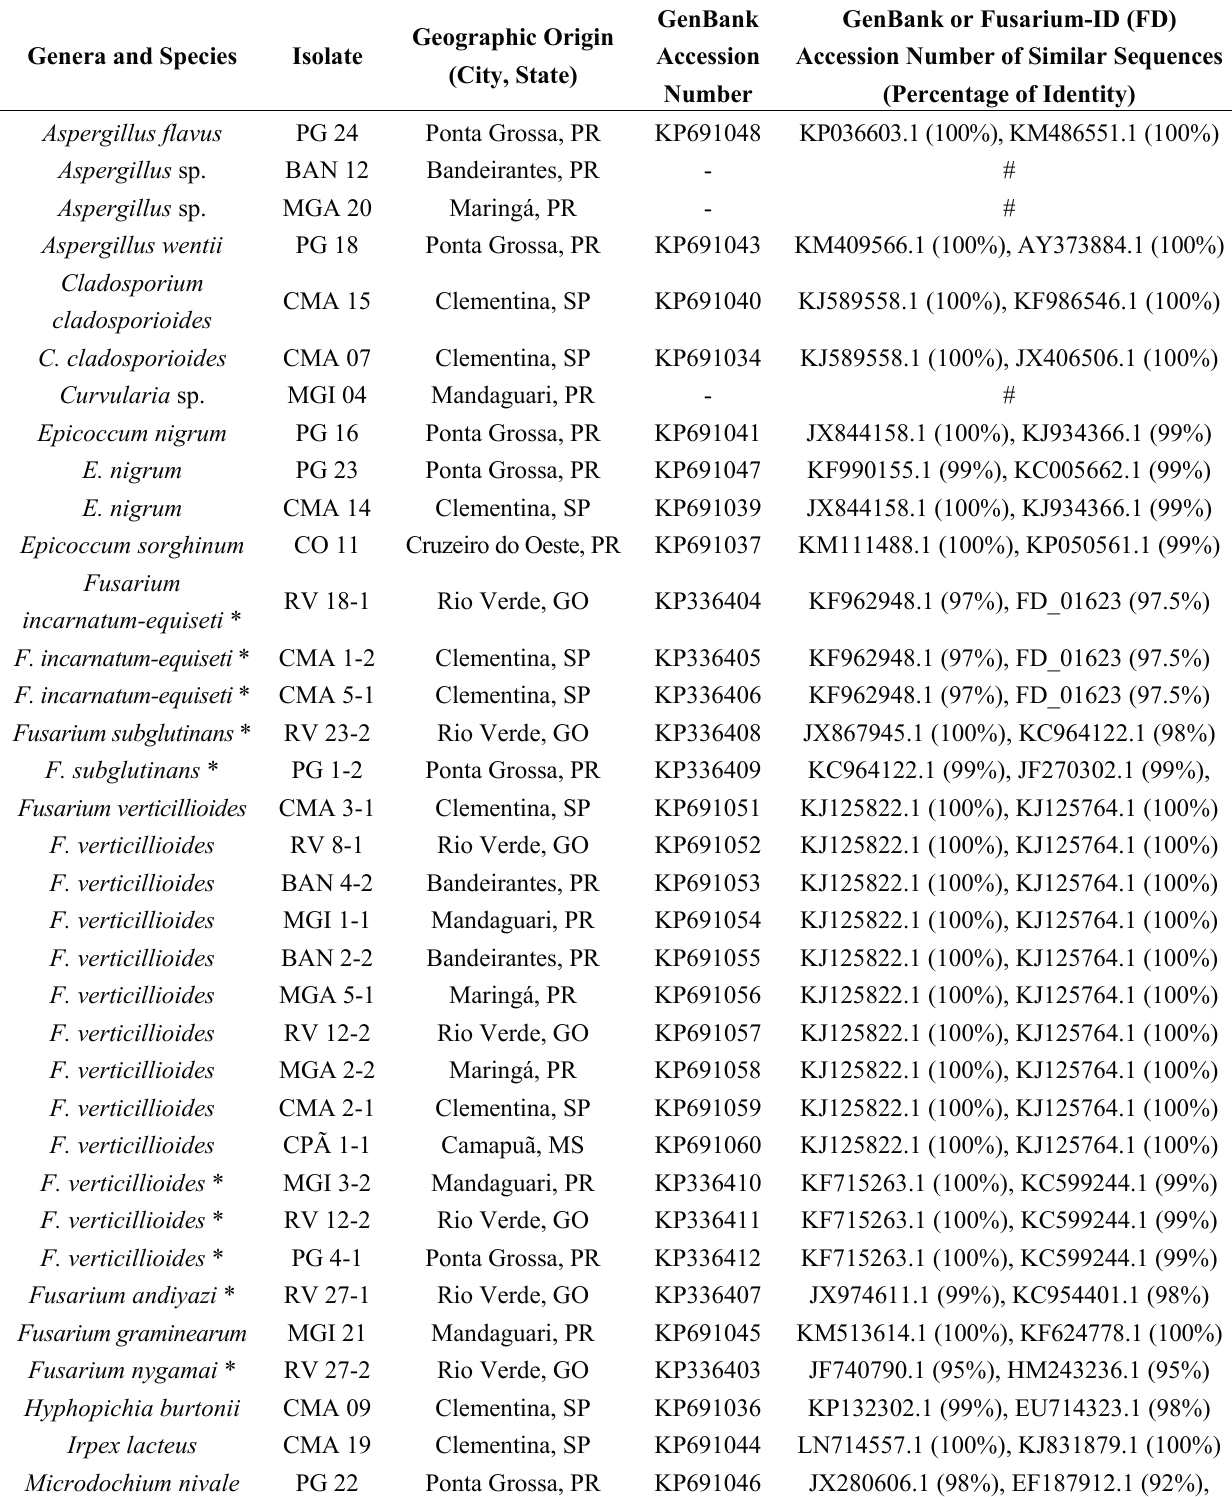
Table 1. Fungal isolates and molecular